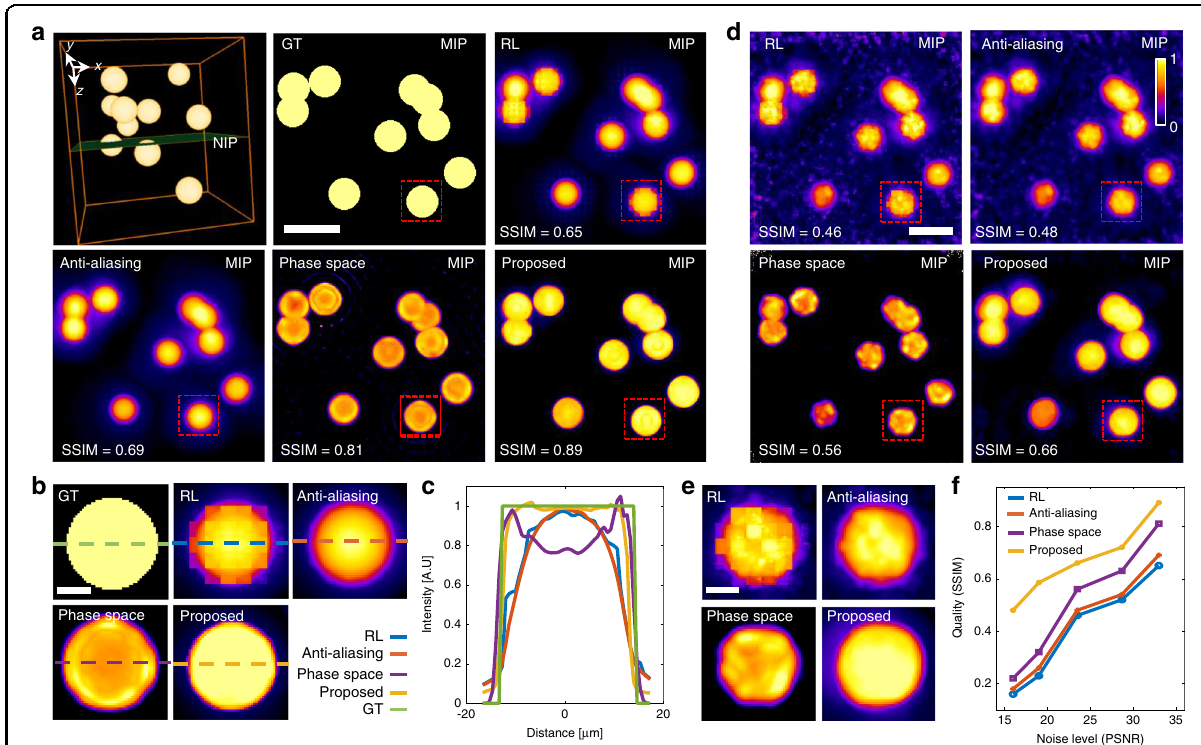
Fig. 3 Reconstruction quality comparisons among different light fi eld reconstruction methods numerically. a 3D rendering of the volume with spherical objects and the maximum intensity projections (MIP) of ground truth volume (GT) and reconstructed volumes by RL, RL with an anti- aliasing fi lter, phase space, and DiLFM. Structural similarity index (SSIM) of different approaches are labeled in each image. b Zoom-in panels of one of the spherical objects indicated by the red dashed boxes in ( a ), which shows DiLFM achieves sharp edge and uniform intensity inside the sphere. c Intensity pro fi le along the dashed line in ( b ). d MIP of reconstructions by different approaches under mixed Gaussian and Poisson noise (noise level PSNR = 23.5). e Zoom-in panels of one of the spherical objects indicated by the red dashed boxes, which shows DiLFM achieves the least-distorted result. f SSIM of different reconstructions in noise levels from PSNR = 15.8 to 33.2 dB. Scale bars in ( a ) and ( d ) are 50 µm, in ( b ) and ( e ) are 10